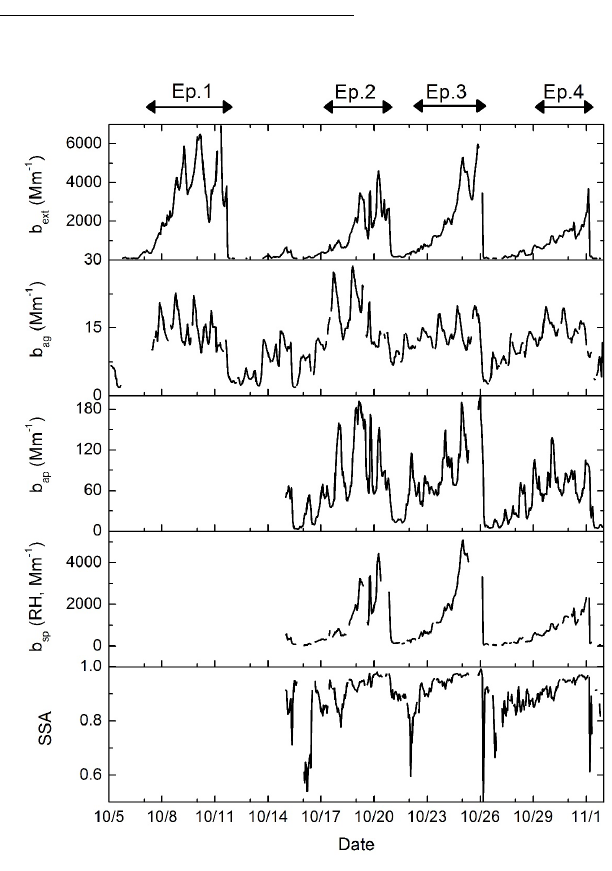
Figure 5. Time series of the atmospheric extinction coefficient b ext , absorption by NO 2 coefficient b ag , aerosol absorption coefficient b ap , ambient aerosol scattering coefficient b sp (RH), and single scat- tering albedo (SSA) in Beijing from 5 October to 2 November